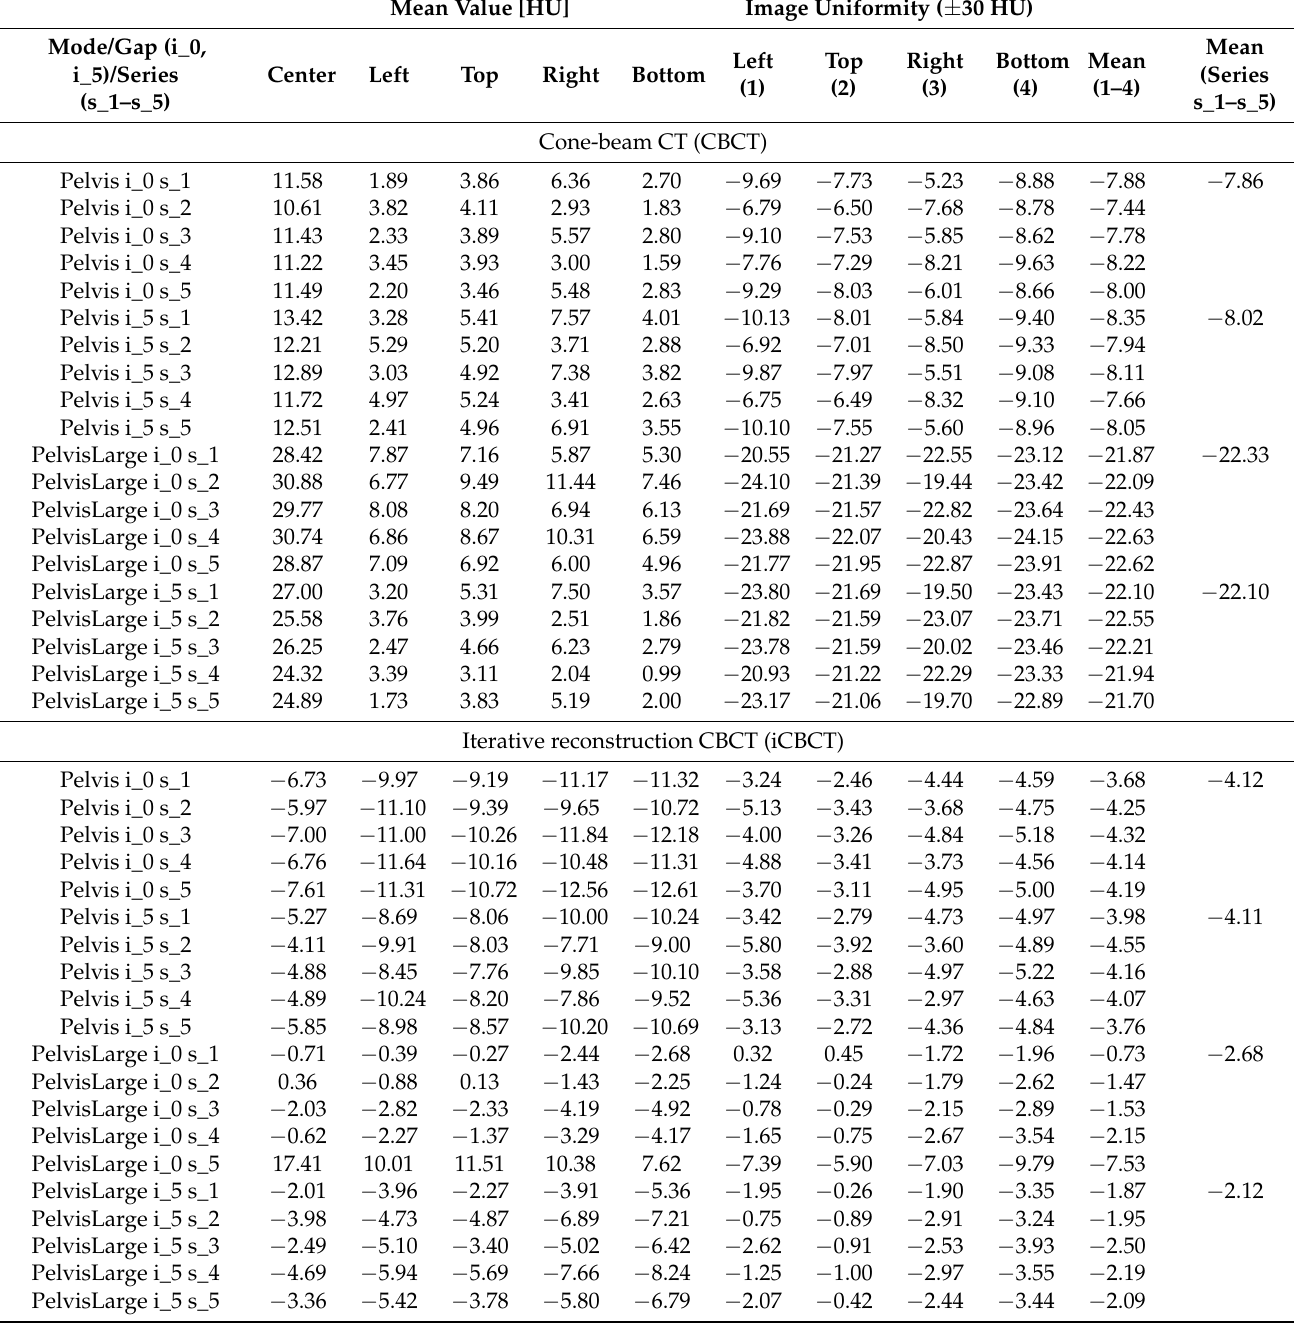
Table 6. Impact of reconstruction algorithms and modes on the image uniformity for scanning the Cathpan ® 504 phantom with the TrueBeam accelerator equipped with CBCT and iCBCT. The results are shown for 0 and 5 min gaps between measurements (i_0 and i_5, respectively) and for 1–5 series (s_1–s_5). VOI: 20 mm diameter, 5 mm